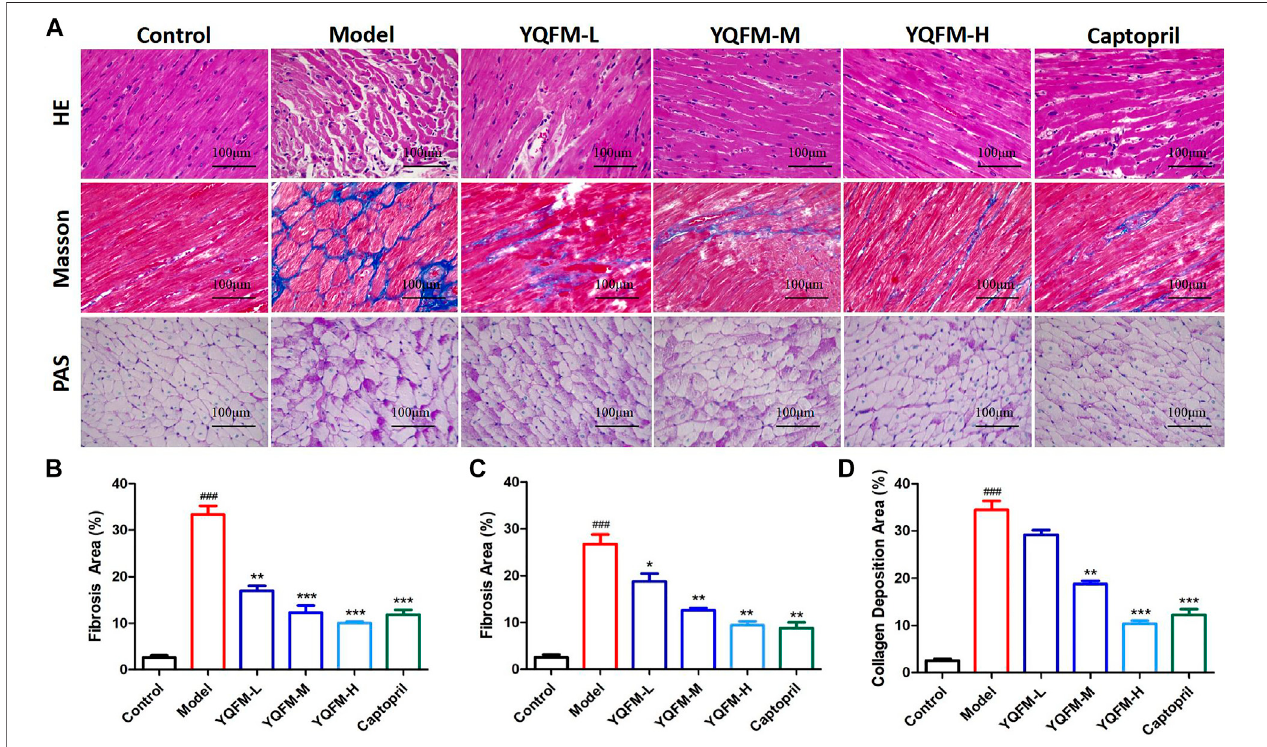
FIGURE 3 | The effect of YQFM on Cardiac Morphology in CHF rat after being treated for 28 d. (A) HE, Masson and PAS pathology section (B – D) staining of the myocardial.( n (cid:2) 6animals/group).Dataaremeans ± SD. # p < 0.05, ## p < 0.01, ### p < 0.001vstheControlgroup,* p < 0.05,** p < 0.01,*** p < 0.001vstheModelgroup.